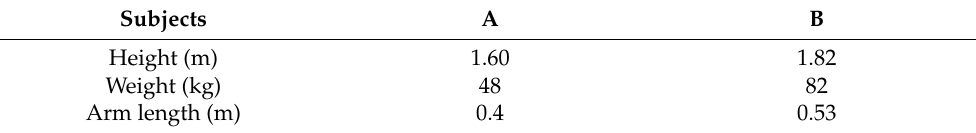
Table 4. Subject